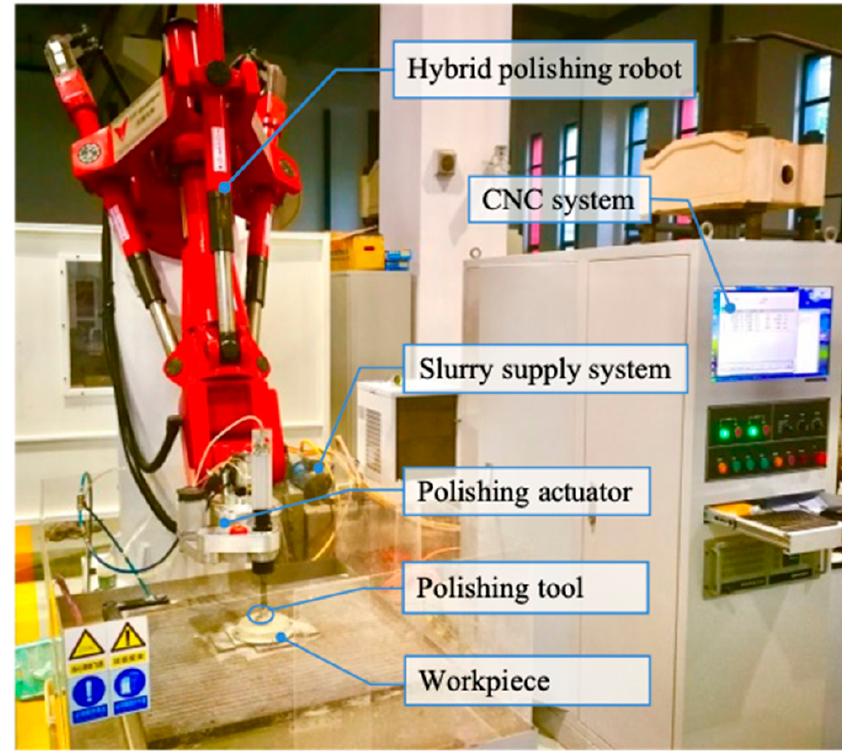
Figure 3. Experimental robotic polishing device for the CCOS process.